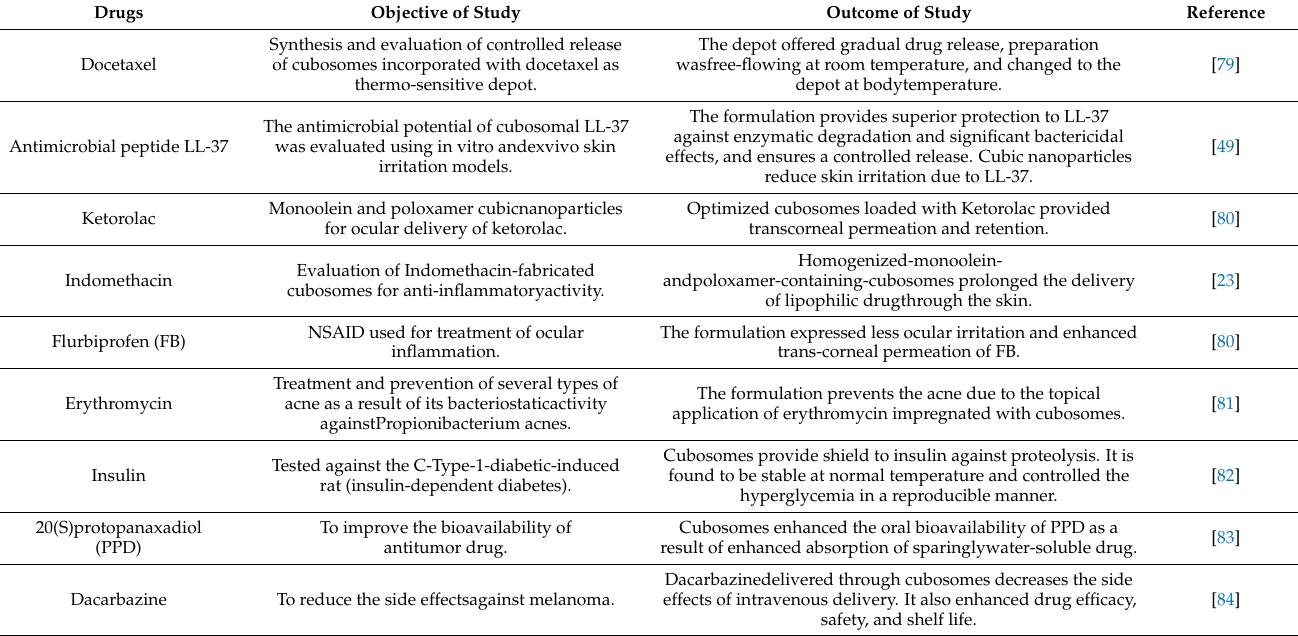
Table 5. Drugs embedded in